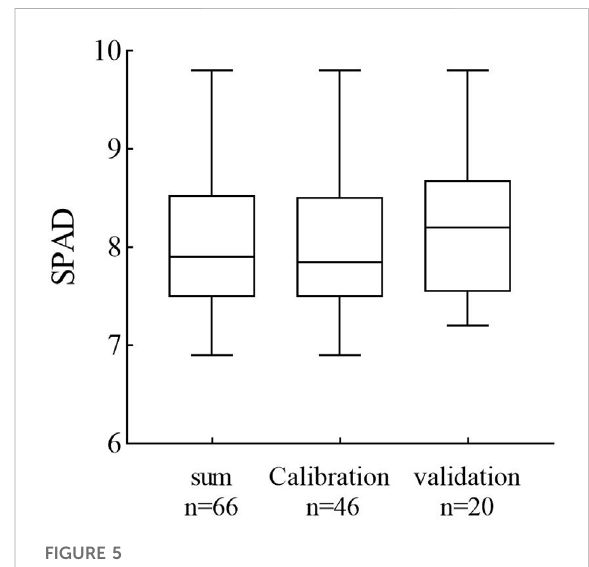
FIGURE 5 Boxplots of Chlorophyll content of S. vulgaris , lower and upper box boundaries represent the quartiles (25% and 75% quantiles, respectively), the whisker is min-max, and the solid lines across each box are the median.